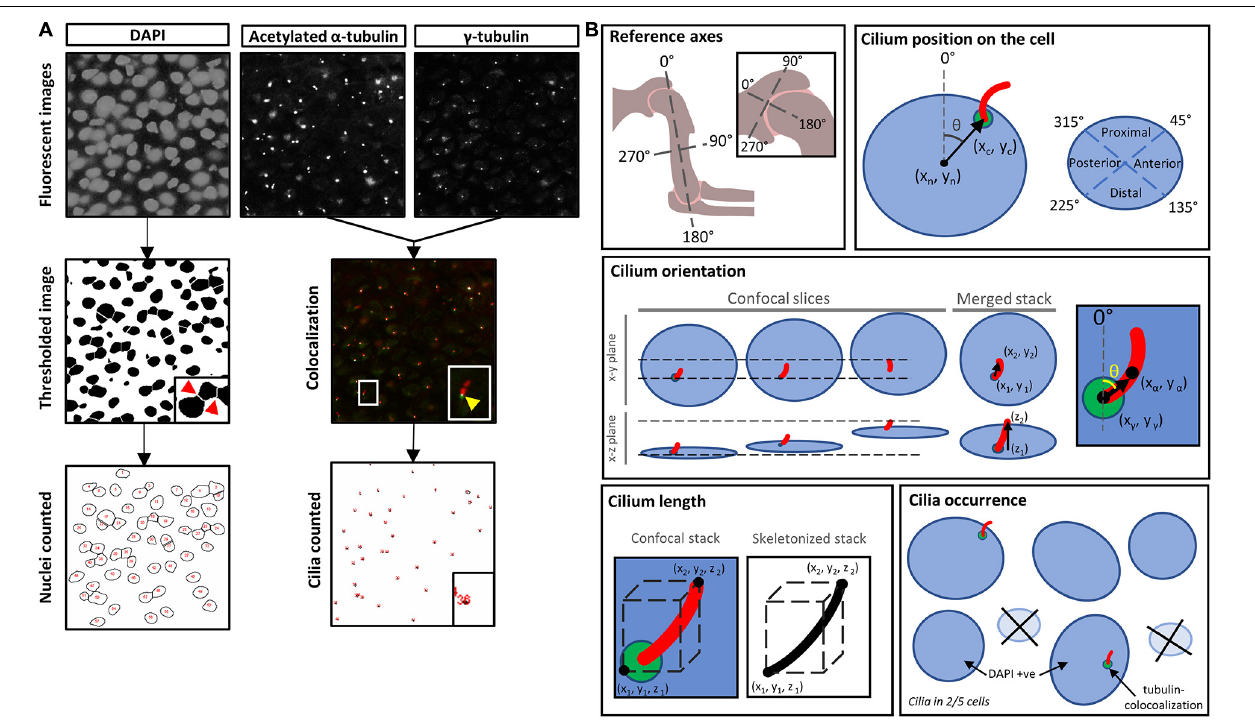
FIGURE 1 | Analysis of cilium characteristics. (A) Images of immunostained nuclei (DAPI) and cilia (acetylated α -tubulin and γ -tubulin) captured, processed separately, and recombined. To count nuclei, images were processed as follows (with corresponding ImageJ functions indicated): the image was smoothed (Gaussian Blur; sigma = 3), converted to binary (Threshold), cleared of noise (Despeckle); nuclei were then separated (Watershed) and counted (Analyze Particles; minimum size = 20 µ m 2 ). In parallel, α - and γ -tubulin images were merged and converted to a binary image of overlapping staining (Colocalization); regions of overlap (indicating cilia) were counted (Analyze Particles). (B) Illustrative overview of parameters measured, as detailed in the text. For cilium position on the cell and cilium orientation analyses, images were aligned to the longitudinal axis of the humerus ( reference axes